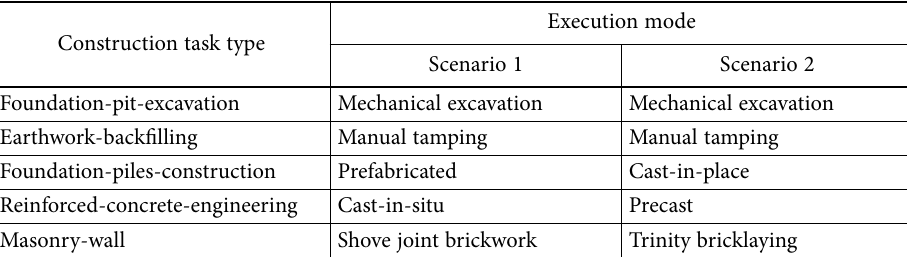
Figure 6. A feasible construction plan for scenario Table 5. Selection of execution modes in two scenarios